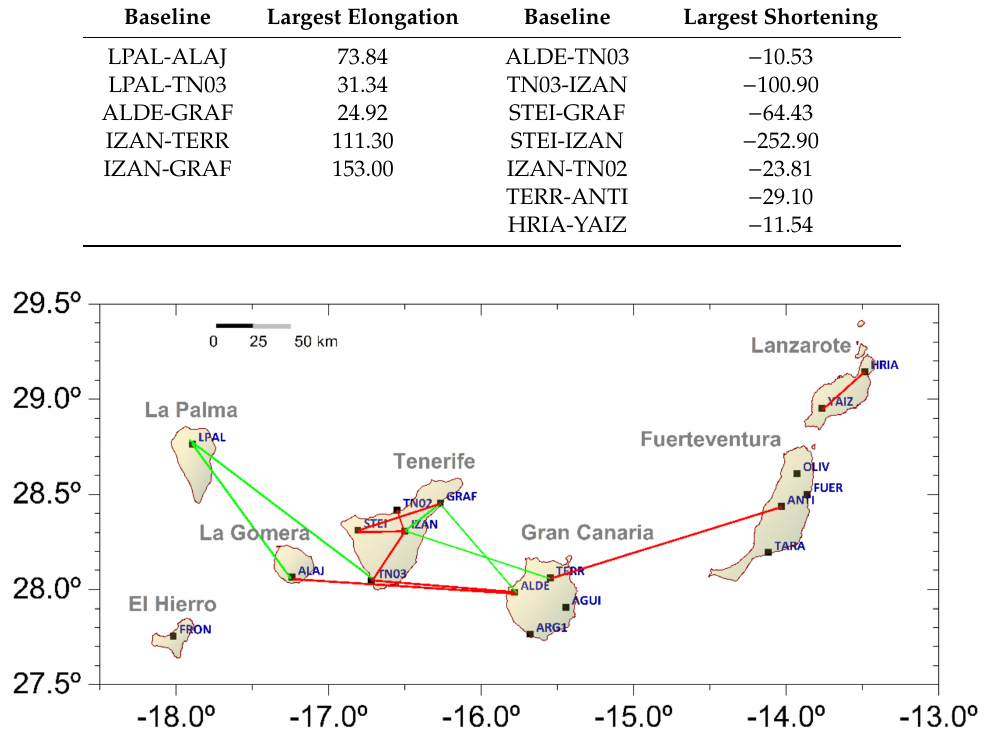
Figure 3. Baselines with the maximum variation in length during the period of observation (2011 to 2017). The green lines indicate the greatest elongation ( ≥ 10 − 8 ), and the red lines indicate the greatest shortening ( ≥ 10 − 8